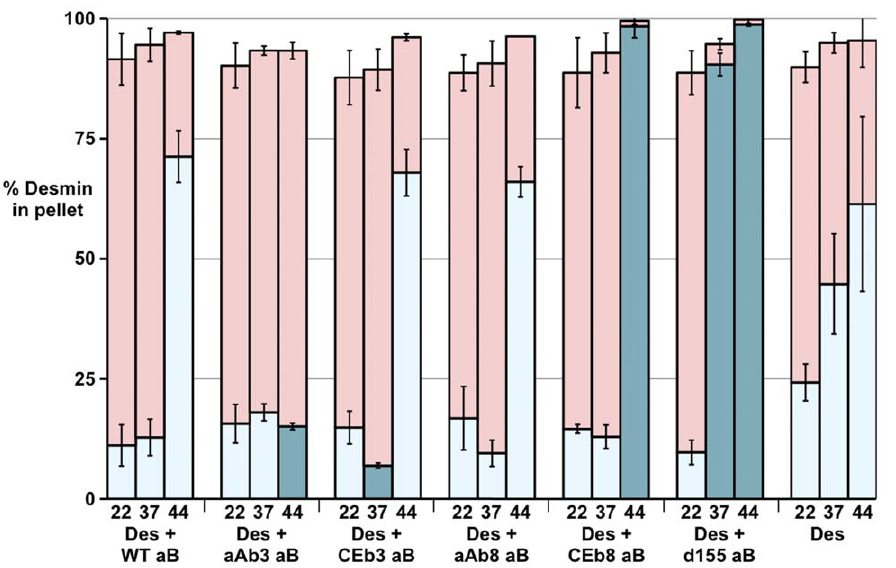
Figure 6. Desmin sedimentation characteristics in the presence of wild type and various a B-crystallin protein constructs. Bar chart of the low-speed (light and dark blue; lower portion of each bar) and high-speed (red) sedimentation assay data for desmin coassembled with either wild type (WT aB) or the various a B-crystallin protein constructs. The percentage of desmin in each pellet fraction at 22, 37 and 44 u C was determined after both low- and high-speed sedimentation assay. The mean % from three independent experiments with its corresponding standard error was calculated for each and then plotted as a composite bar chart. The assembled desmin is pelleted by high-speed sedimentation assay. At low-speed, only the assembled filaments that have formed filament-filament interactions are pelleted. Neither temperature nor the presence of the various a B- crystallin protein constructs changed significantly the proportion of desmin pelleted in the high-speed assay. The significant differences are seen in the low-speed sedimentation assay. At 44 u C, a A b 3 a B-crystallin (Des + aAb3 aB) produced a significant reduction in desmin pellet fraction (dark blue bar). Conversely, both the CE b 8 (Des + CEb8 aB) and D 155–165 (Des + d155 aB) a B-crystallin protein constructs caused significant increases in the proportion of desmin pelleted at 44 u C (dark blue bars). This was also true at 37 u C for the D 155–165 (Des + d155 aB) a B-crystallin protein